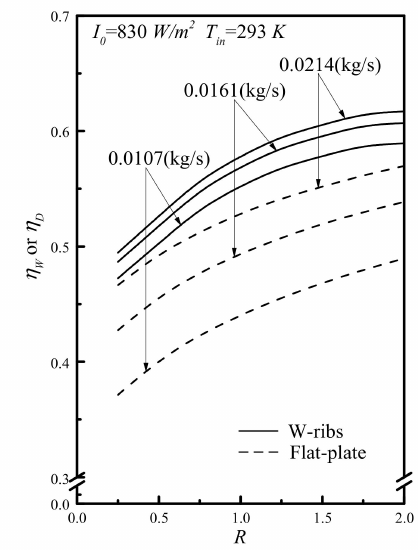
Figure 8. Collector thermal e ffi ciencies of various configurations.